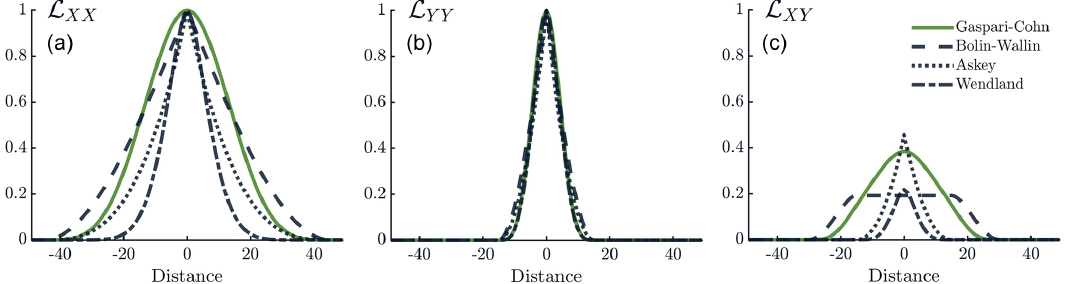
Figure 1. There are four multivariate localization functions shown in three panels. Panel (a) shows the function L XX used to localize the large process, X . Panel (b) shows the function L YY used to localize the small process, Y . Panel (c) shows the cross-localization function L XY . In each panel, the color of the line shows the different multivariate functions, i.e., Gaspari–Cohn (green; solid), Bolin–Wallin (dark; dashed), Askey (dark; dotted), and Wendland (dark; dash-dot). In the case of univariate localization, the functions in the middle panel are used to localize all processes. The within-component localization radii are R YY = 15 and R XX = 45 for all functions. The cross-localization radii are R XY = 30 for Gaspari–Cohn and Bolin–Wallin and R XY = 15 for Askey and Wendland.